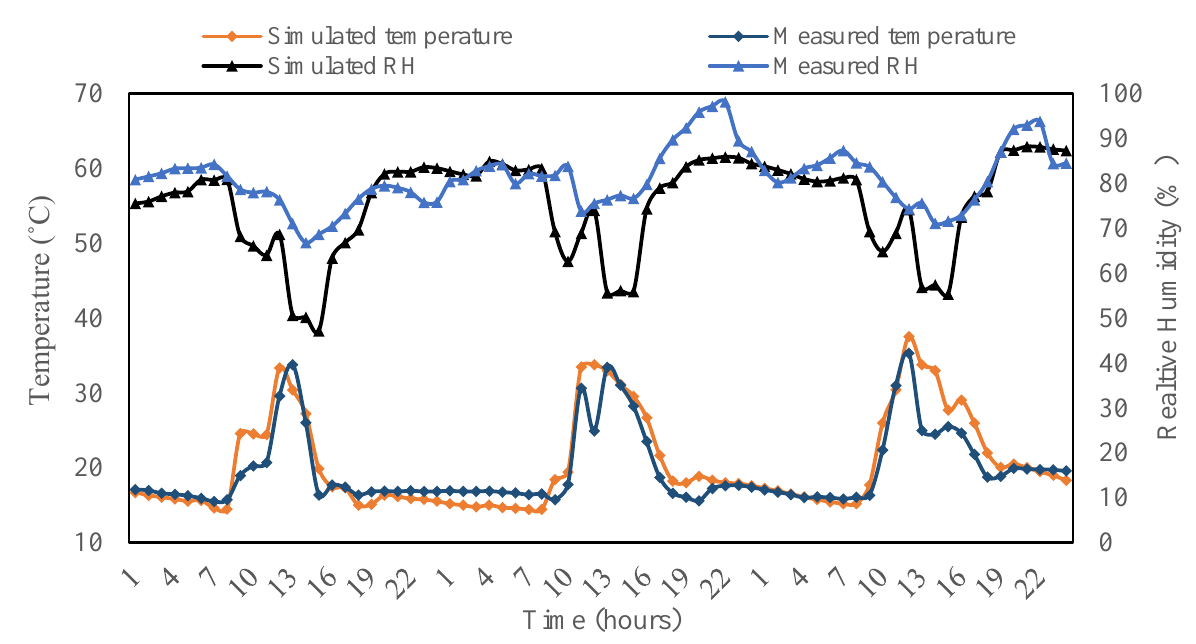
Figure 7. The comparison of the measured and predicted indoor air temperature and RH in the greenhouse. Similarly, the overall trend of the predicted indoor RH is close to the measured one except during the noon ventilation periods; the average discrepancy is about 7.0%. The high discrepancy could be caused due to two factors. Firstly, actual plant transpiration was very small as the plants were transplanted a few days before the experiment. The evaporation